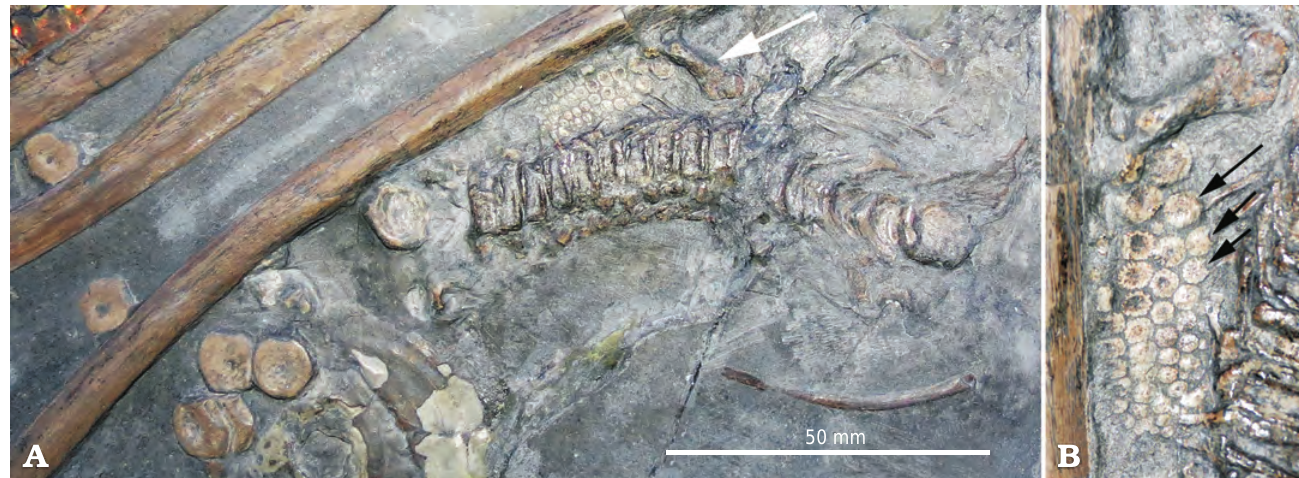
Fig. 7. Embryo of Ichthyosaurus somersetensis Lomax and Massare, 2017 (NLMH 106234) from the Lower Jurassic (lower Hettangian) of Doniford Bay, Watchet, Somerset, UK. A . Articulated vertebral column, isolated forefin, probable scapula (white arrow), ribs, and isolated centra. B . Close-up of the forefin. Arrows point to probable notching of the ?radiale, ?distal carpal, and